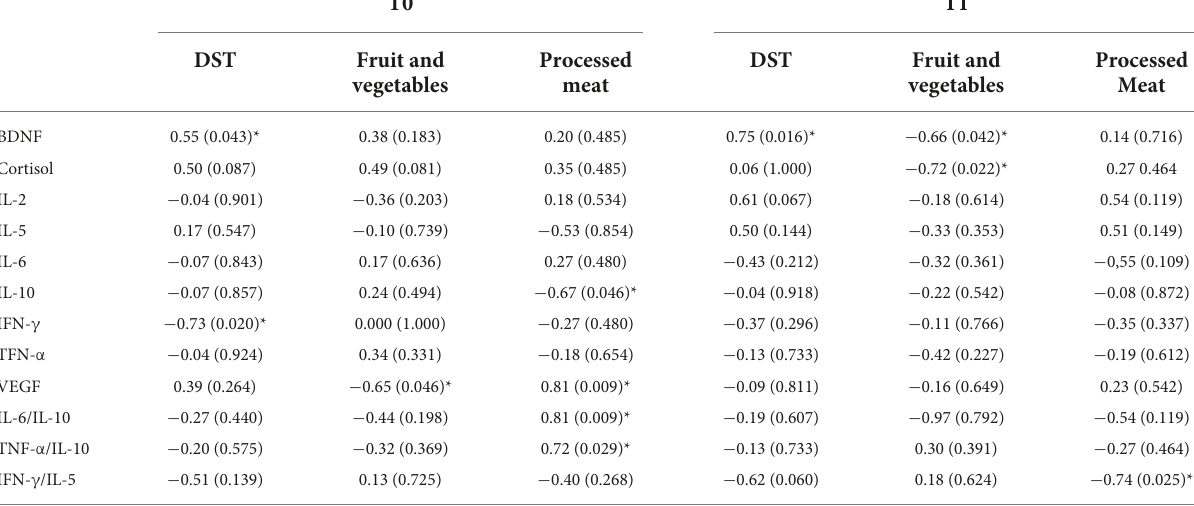
TABLE 5 Association of Dietary Screening Tool (DST), its parts scores and serum markers by Spearman correlations analysis before (T0) and 6 months of physical distancing (T1). T0 T1 DST Fruit and Processed DST Fruit and Processed vegetables meat vegetables